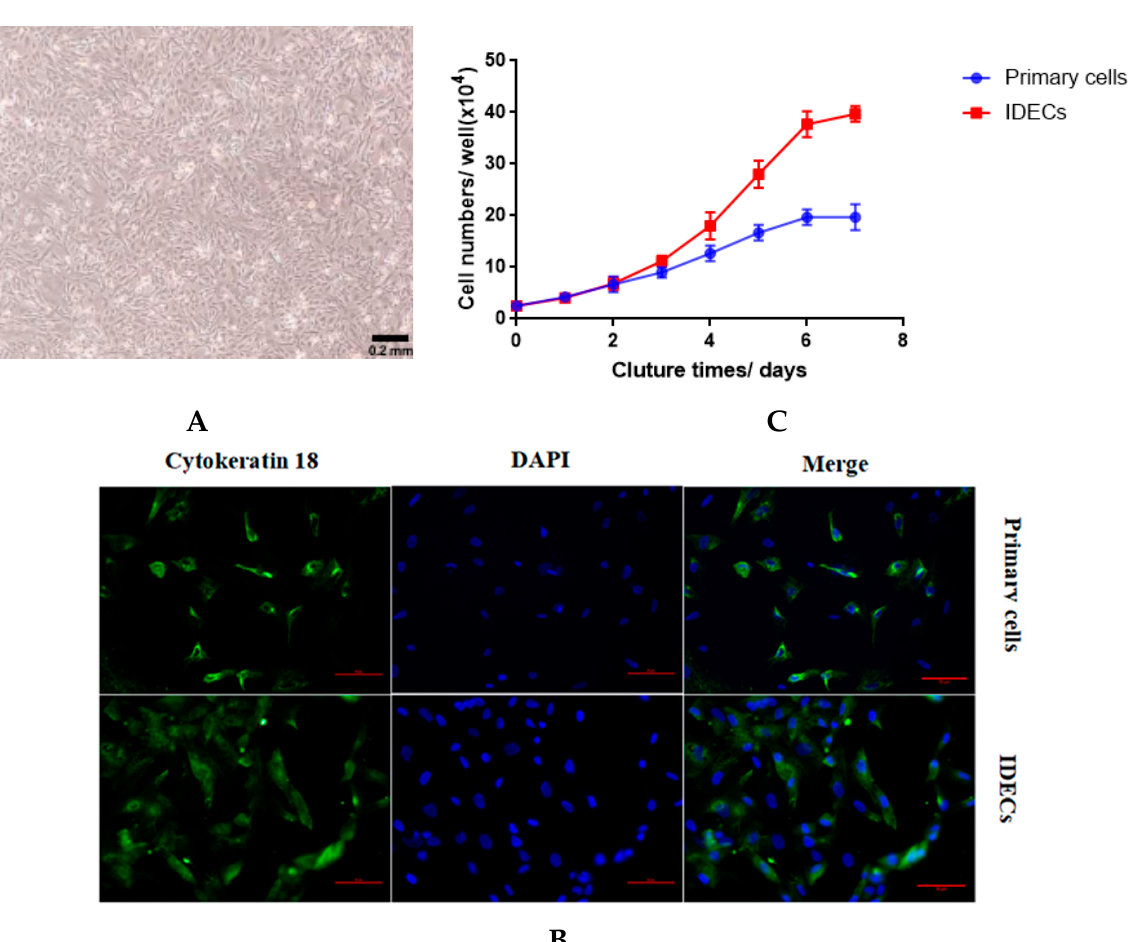
Figure 2. Characterization of immortalized duck intestinal epithelial cells(IDECs). ( A ) Morphology of IDECs at passage 30 under microscope. ( B ) The immunofluorescence study for cytokeratin 18. ( C ) Primary cells and IDECs were cultured for 7 days and average cell numbers were counted on different days. Data are represented as the mean ± SE ( n = 3).